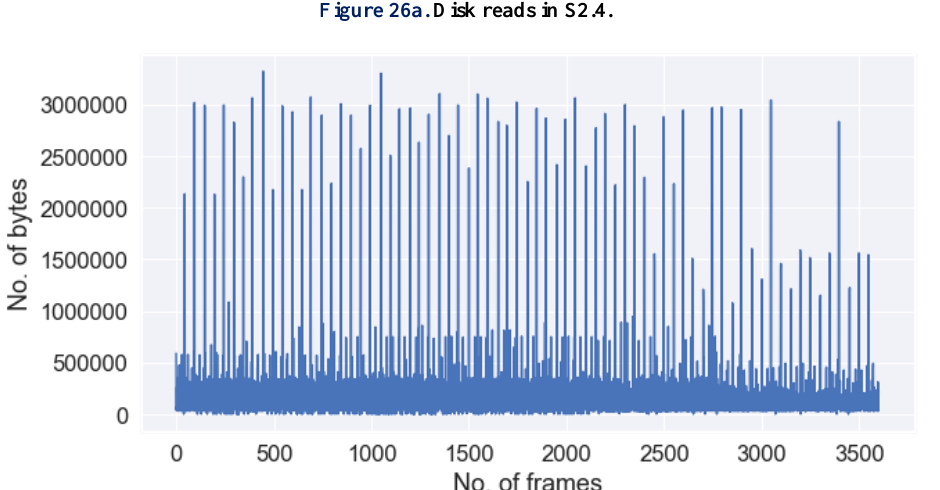
Figure 26b. Disk writes in